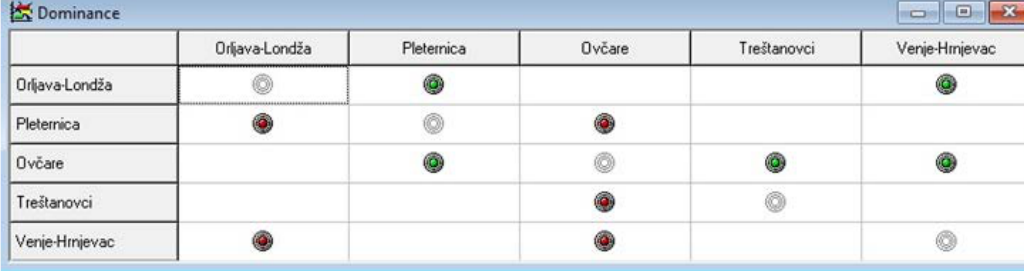
Figure 10. Dominance matrix of mutual relationships among alternatives for Scenario 1.